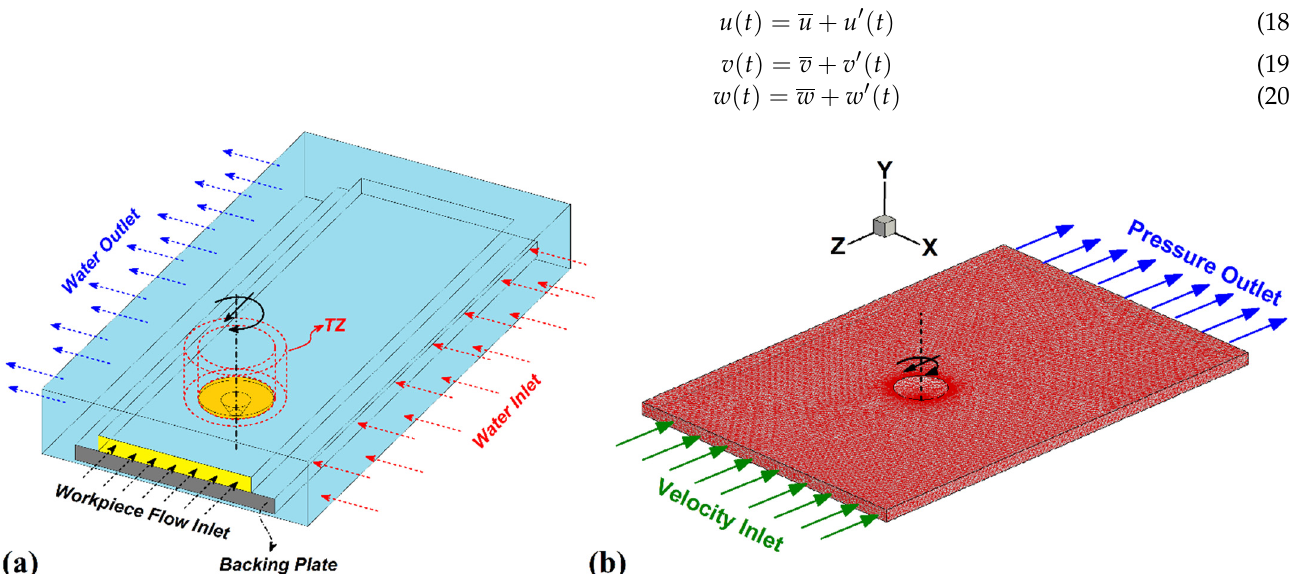
Figure 3. Isometric view of ( a ) water flow domain, ( b ) meshed domain for simulation of FSW and UFSW process.